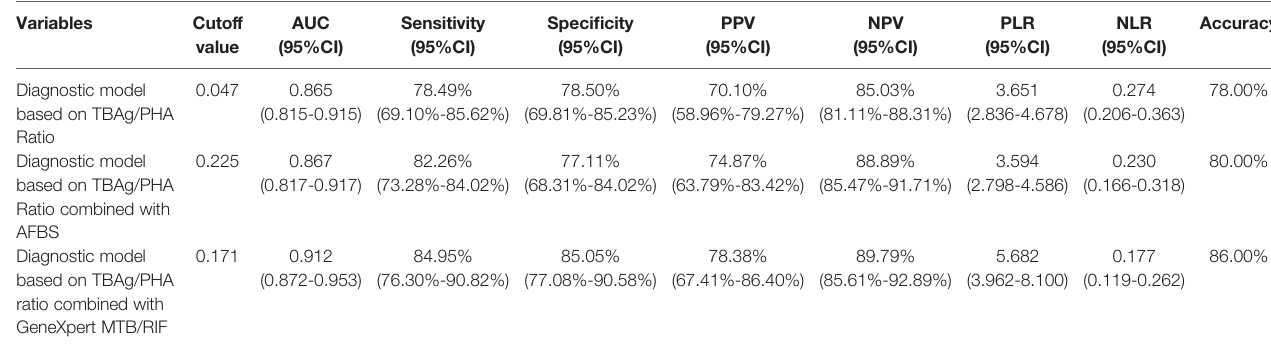
TABLE 3 | The predicting performance of various diagnostic methods for distinguishing between TB and NTB in the validation cohort (Sino-French New City Hospital).